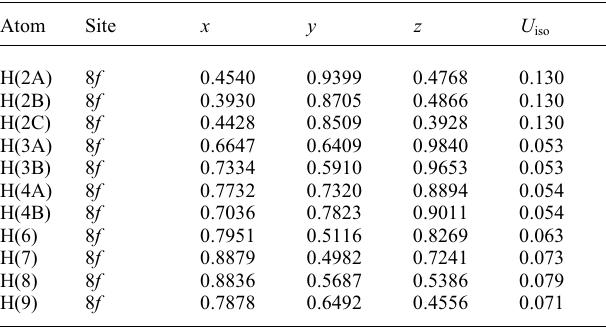
Table 2. Atomic coordinates and displacement parameters (in Å 2 )